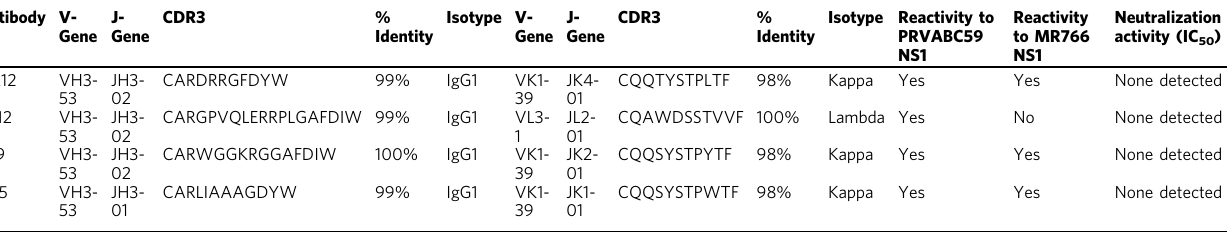
Table 1 Antibody characteristics. VJ assignments, CDR3 sequences, % identity, and isotype for the antibody clones. IMGT/V- QUEST software was used to assign the germline reference for IGHV and IGLV and determine % identity to germline. ELISAs were done to determine reactivity and microneutralization assays were performed to determine neutralization activity at concentrations up to 100 µ g per